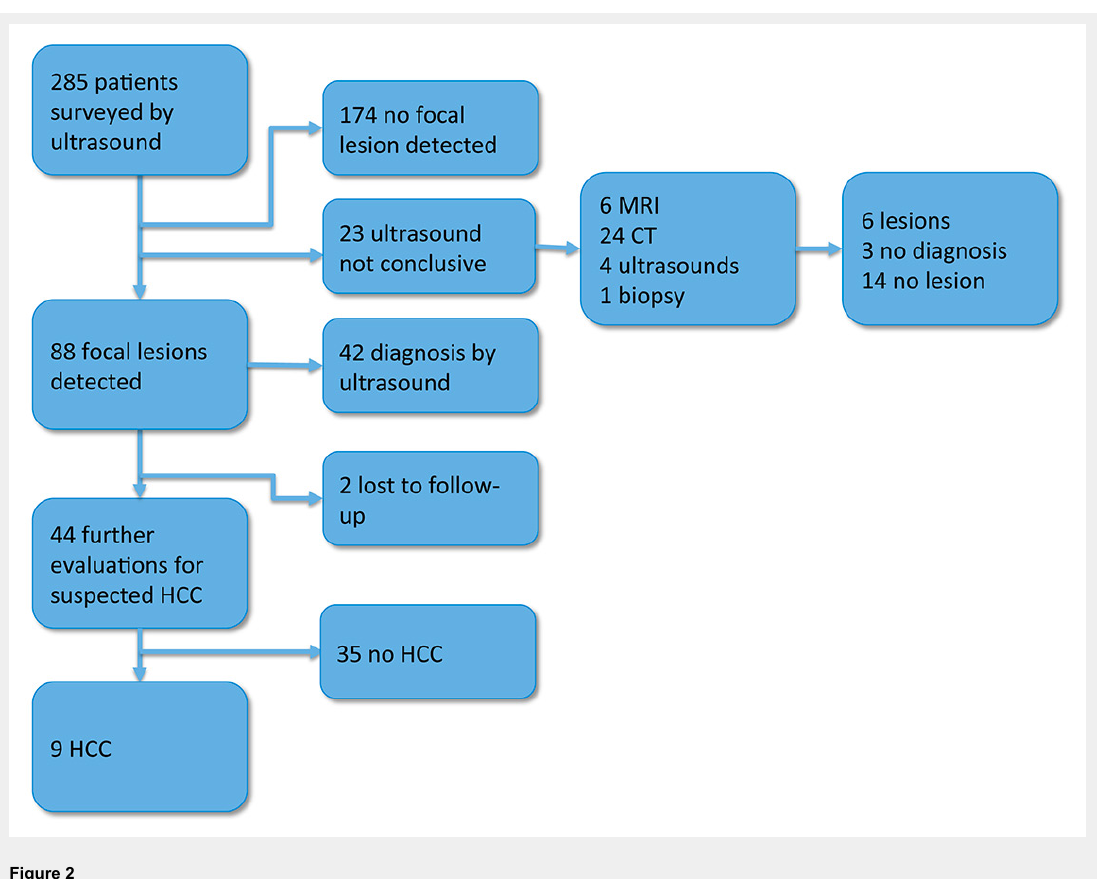
Figure 2 Diagnostic work-up and results in the 285 patients surveyed at the University Hospital Basel in the years 2011 and 2012. CT = computed tomography; HCC = hepatocellular cancer; MRI = magnetic resonance